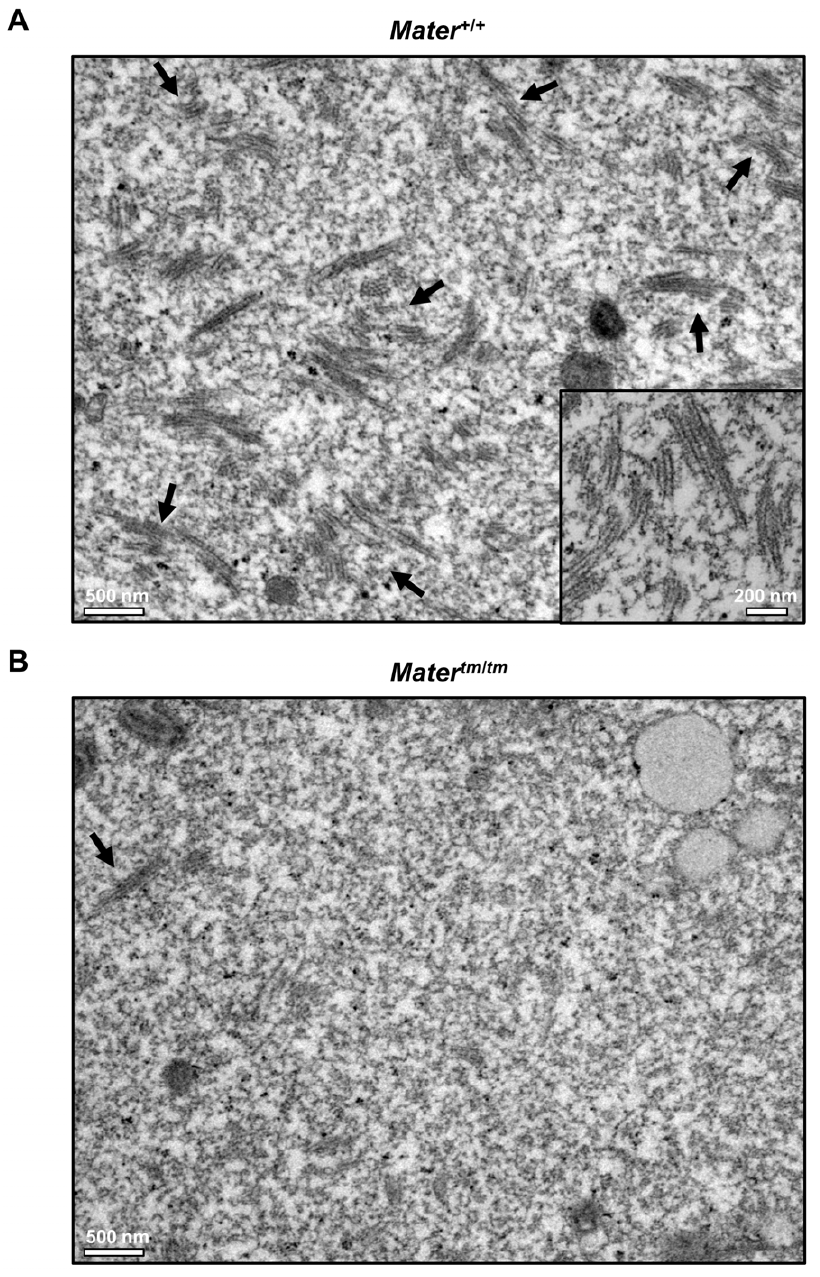
Figure 3. EM analysis reveals that the volume fraction of CPLs is reduced in Mater tm/tm oocytes. ( A ) Representative TEM image (x11,500) of the ultrastructure of Mater + / + GV oocytes. A high magnification (x26,500) image of the lattice structure is shown in the inset. ( B ) Representative TEM image (x11,500) showing the ultrastructure of Mater tm/tm GV oocytes. Arrows in A and B indicate CPLs.